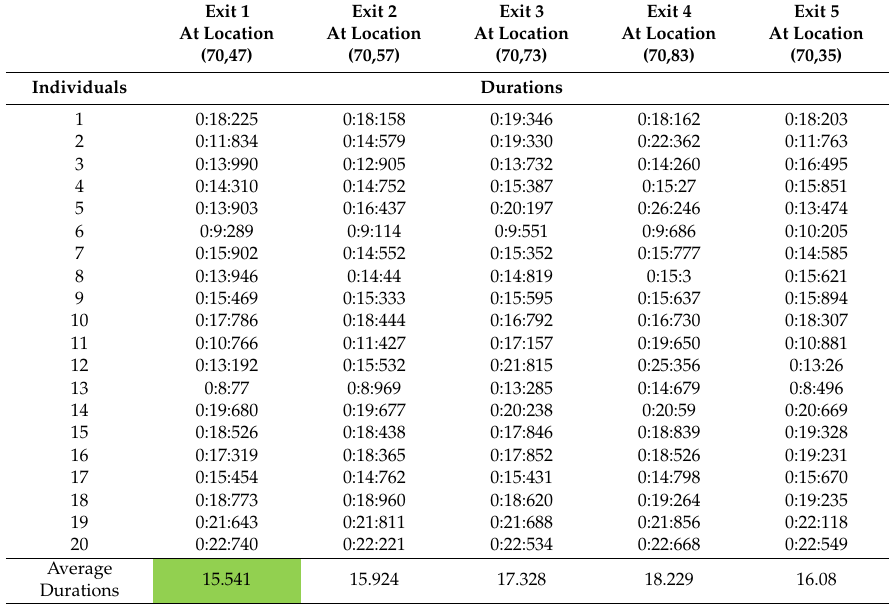
Table 4. Result of scenario #A for 20 nonfamiliar evacuees for 5 exit door locations.